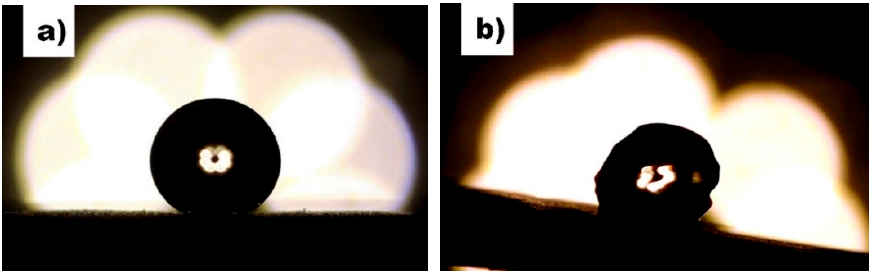
Figure 9. Images of contact angle measurements: ( a ) WCA = 155 ± 0.6° and ( b ) SA = 5 ± 0.1°. Both characteristics leads to a superhydrophobic surface with self-cleaning properties.